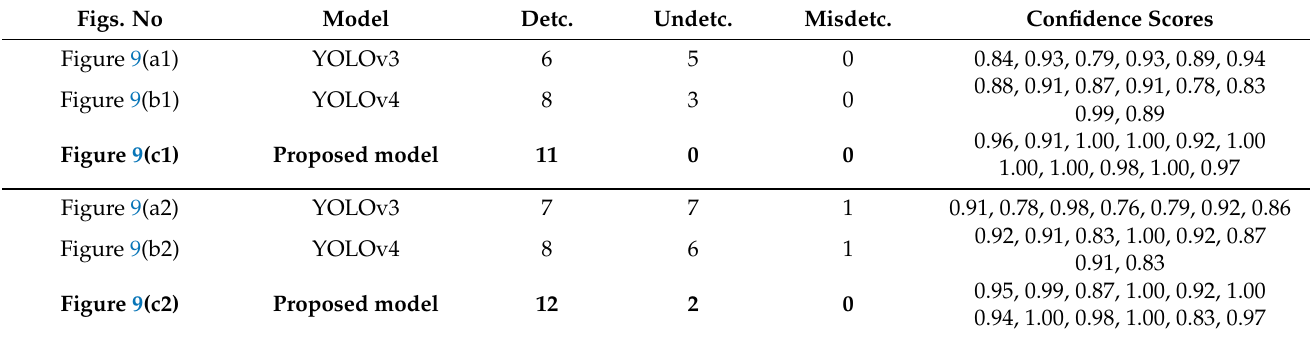
Figure 9. Comparison of detection result for apple rust on two distinct apple leaves from three models: ( a1 , a2 ) YOLOv3; ( b1 , b2 ) YOLOv4; ( c1 , c2 ) proposed model. Table 7. Comparison of detection results between YOLOv3, YOLOv4, and proposed model for apple rust detection as shown in Figure 9. Bold highlights the best result obtained from corresponding model